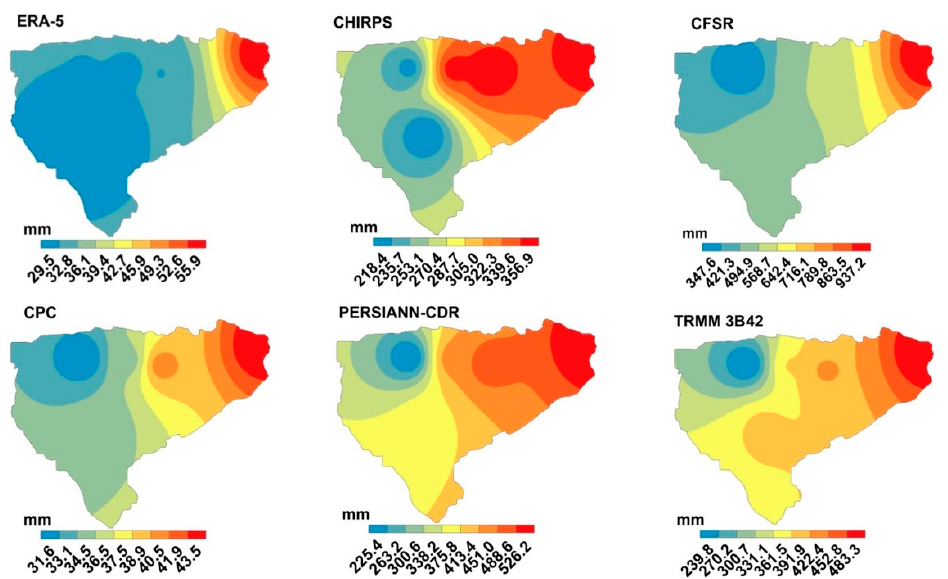
Figure 7. Maps displaying the average annual rainfall during 1998–2007 by the di ff erent precipitation products. The legend was not homogenized to improve the presentation of the di ff erent products, given that some datasets show very low estimates compared to ground observations. Table 8. Summary of the annual average of rainfall rates (mm) by the di ff erent